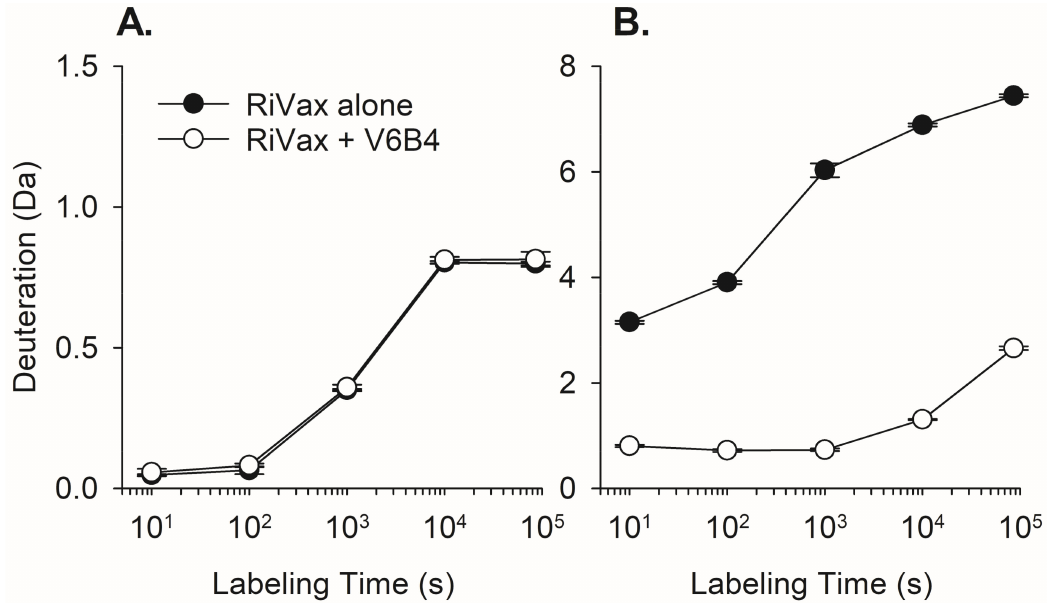
Figure 3. Hydrogen exchange (HX) kinetics of two representative RiVax peptides in presence of V6B4. Hydrogen deuterium exchange kinetics of two representative RiVax peptides in presence of V6B4. ( A ) Peptide 14 (56–59), where the HX rate was not affected by association with V6B4. ( B ) Peptide 94 (205–217) where the rate of HX was substantially slowed by V6B4. Significance limit for HX differences was defined as described in the Experimental